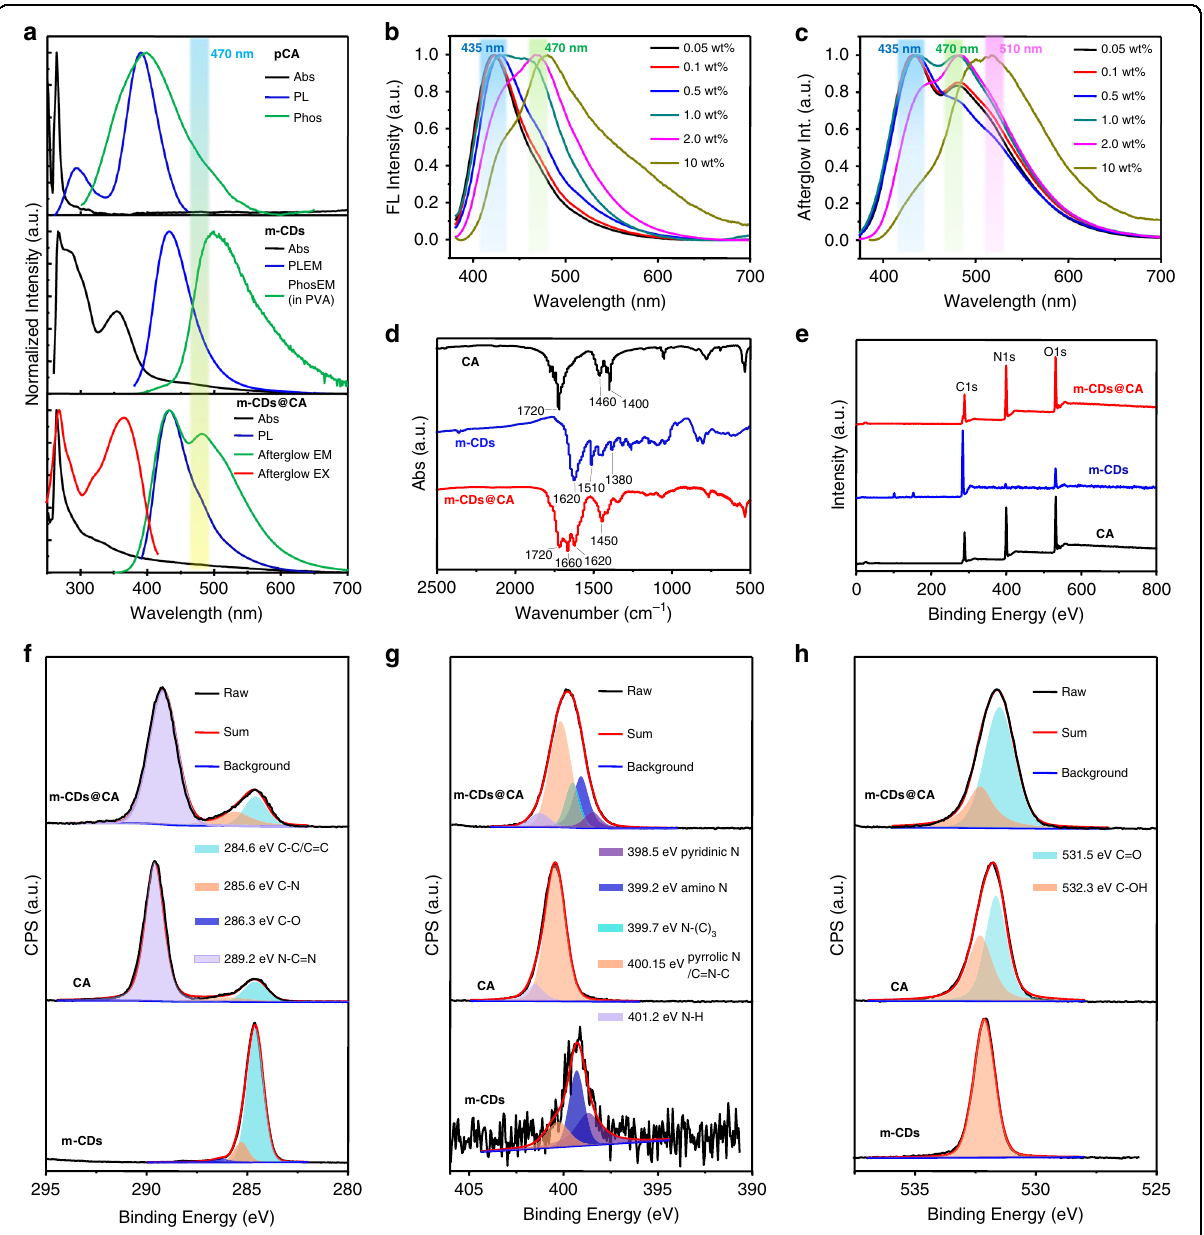
Fig. 4 The photophysical properties and chemical composition of CA, m-CDs and m-CDs@CA. a UV-Vis absorption (Abs), photoluminescence (PL) emission and excitation spectra of CA (top), m-CDs (middle), and m-CDs@CA (bottom) under ambient conditions. PL, phosphorescence emission and excitation spectra of m-CDs were measured from their ethanol dispersion and PVA fi lm, respectively; PL, afterglow emission and excitation spectra of CA and m-CDs@CA (0.1 wt% sample) are measured from their powders. The absorption spectra of m-CDs, CA and m-CDs@CA were obtained from DMF dispersions of each material. Phosphorescence was abbreviated as Phos in this fi gure for clarity. b, c PL ( b ) and afterglow ( c ) emission spectra of m-CDs@CA with different ratios of m-CDs under 365 nm excitation. d, e FT-IR ( d ) and XPS ( e ) spectra of m-CDs, CA, and m- CDs@CA. f – h High-resolution XPS spectra and the corresponding fi tting curves of the C 1 s ( f ), N 1 s ( g ), and O 1 s ( h ) core levels of the CA, m-CDs, and